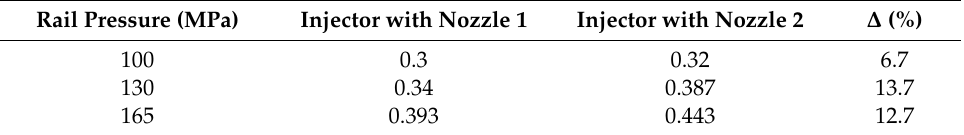
Table 5. Estimated volumetric cyclic flow of fuel by the electromagnetic injector (mL).